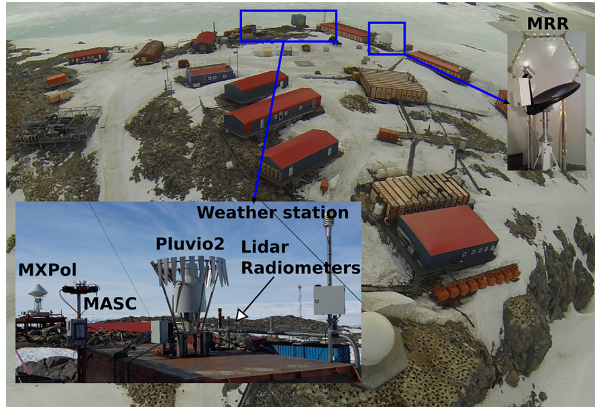
Figure 2. Main instruments deployed at DDU over the time period ranging from November 2015 to November 2016 (the MRR is, how- ever, still collecting observations at the time of